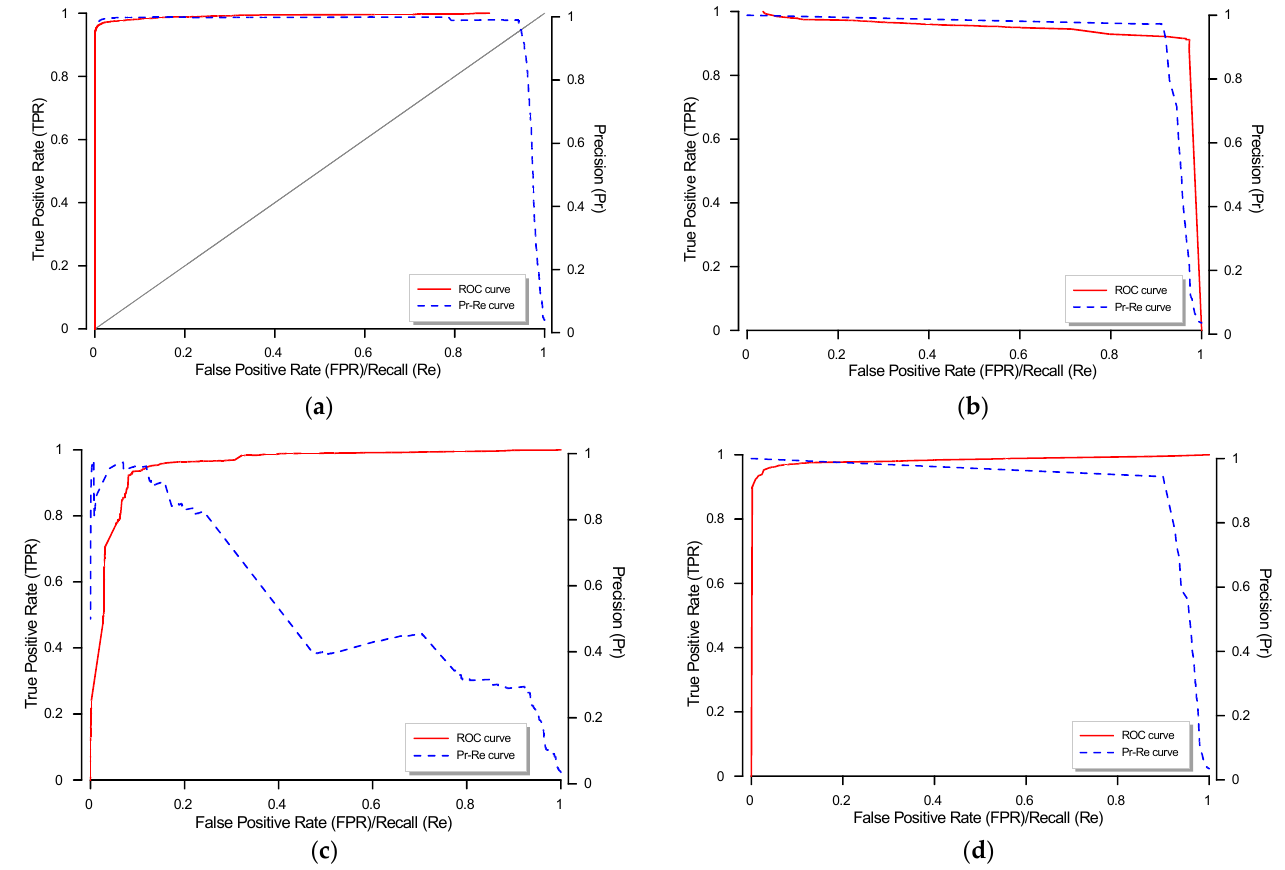
Figure 6. Receiver operating characteristic (ROC) and Precision-Recall (Pr-Re) curves for classification results provided by the proposed methodology for ( a ) 2013, ( b ) 2014, ( c ) 2015, and ( d ) 2016. According to the ROC profiles, the proposed method tends to deliver high True Positive Rates (TPR) and low False Negative Rates. According to the Pr–Re curves, there is a good balance between the Precision and Recall measures. The Area Under Curve (AUC) measurements for both ROC and Pr-Re profiles quantify the high effectiveness of the introduced method.